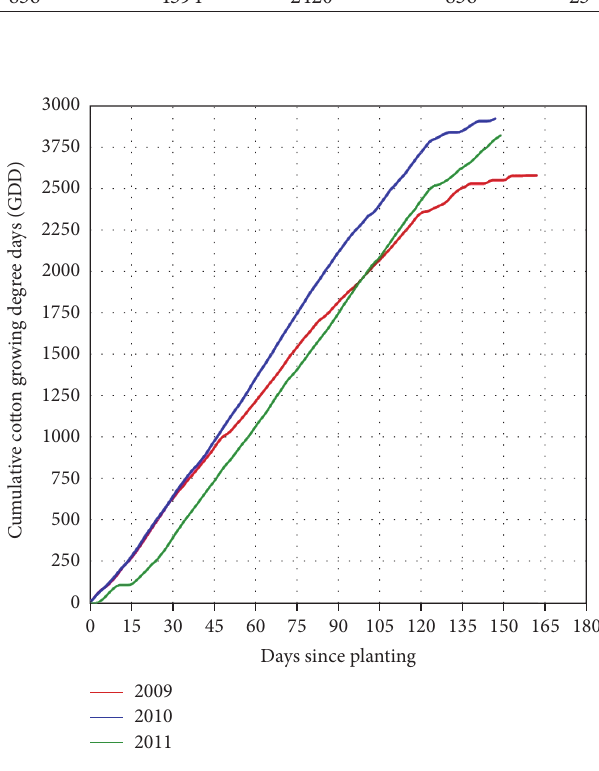
Figure 1: Cumulative precipitation (mm) for days since planting at E. V. Smith Research Center from 2009 to 2011.